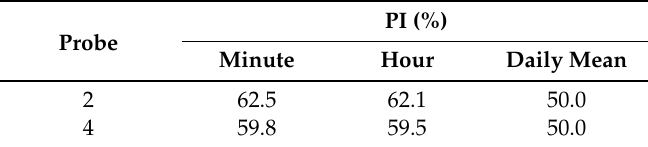
Table 7. Performance Index (PI) calculated as the percentage of time in which the RH values of the new environment are maintained inside the acceptable bands of tolerance during the period from 14 February to 26 March 2016. The bands of tolerance have been determined applying the EN 15757:2010 recommendations to datasheets of difference sampling